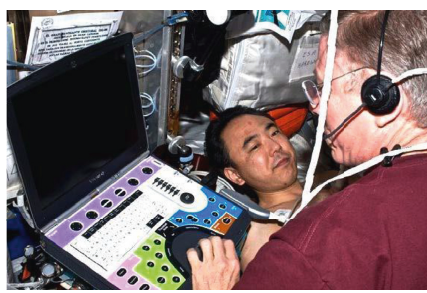
Figure 4: American astronaut Michael E. Fossum assessing the Japanese astronaut with CU device onboard of the International Space